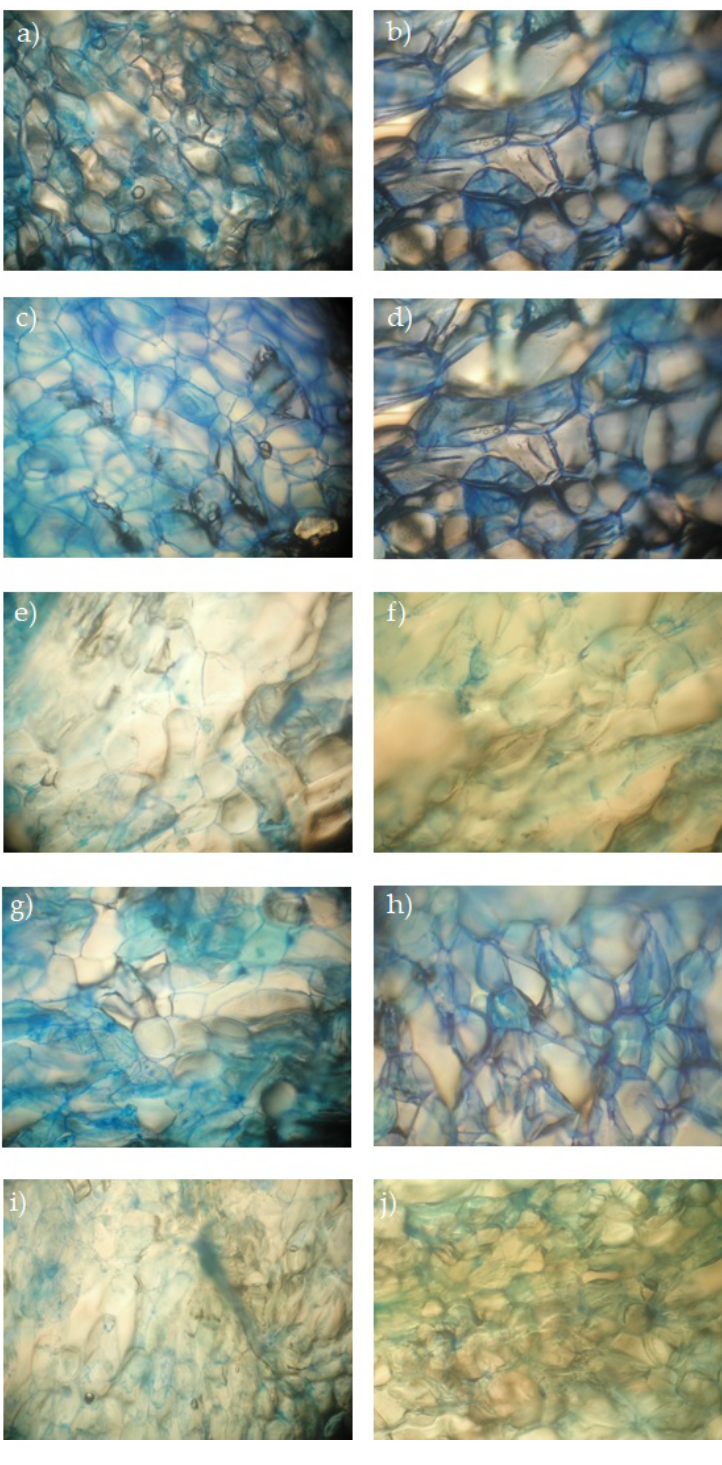
Figure 5. Cell viability of parenchyma apple tissue stained with methylene blue after vacuum impregnation and storage. ( a ) Fresh at 0 h, ( b ) fresh at 24 h, ( c ) VI at 0 h, ( d ) VI at 24 h, ( e ) AA at 0 h, ( f ) AA at 24 h, ( g ) CaLac at 0 h, ( h ) CaLac at 24 h, ( i ) AA+CaLac at 0 h, and ( j ) AA+CaLac at 24 h. Fresh, control sample; VI, vacuum impregnated with isotonic solution; AA, VI with ascorbic acid; Ca-Lac, VI with calcium lactate; AA+CaLac, VI with